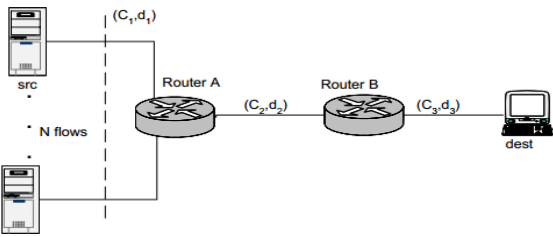
Figure 11. The network model to simulate the